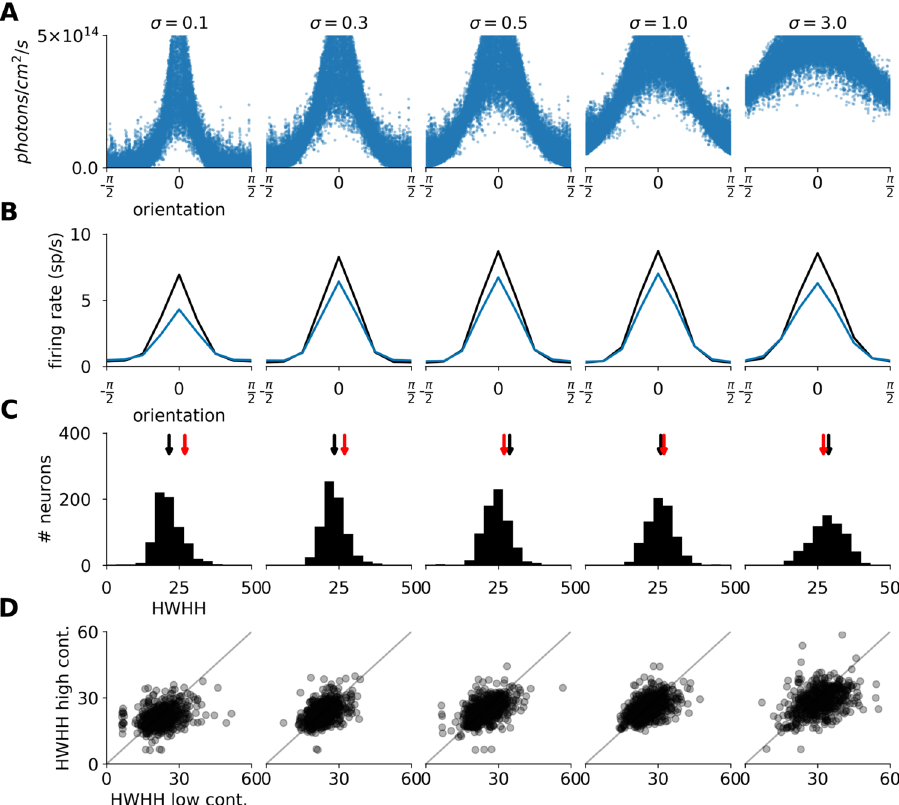
Figure 6. Width of orientation tuning as a function of the sharpness parameter of the optogenetic stimulation protocol in the OptoExc condition. Each column corresponds to cortical optogenetic stimulation simulation where different parameters of the stimulation orientation sharpness σ were used. ( A ) Illumination intensity at the cell body as a function of the orientation preference of the given neuron. ( B ) Mean of the orientation tuning curves across all recorded neurons (after realignment on their respective orientation preference). ( C ) The histogram of tuning width measured as HWHH at maximum contrast. The black arrows on top mark the mean of the distribution. The red arrows mark the mean HWHH of the natural vision condition. ( D ) The scatter plot showing the orientation tuning width measured as HWHH at minimum and maximum